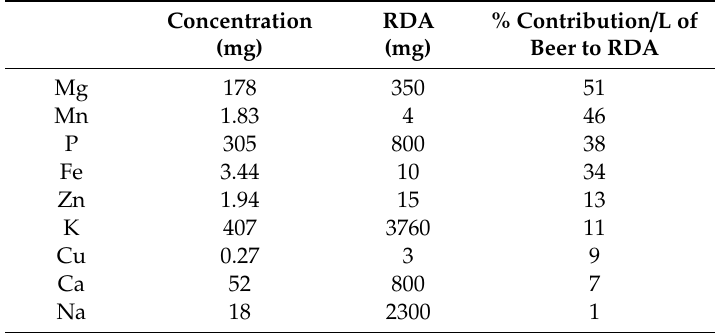
Table 4. The mineral content in umqombothi derived from sorghum adjunct and percentage contribution to the recommend daily allowance (RDA) by a litre of the beer. Concentration RDA % Contribution / L of (mg) (mg) Beer to RDA Mg 178 350 51 Mn 1.83 4 46 P 305 800 38 Fe 3.44 10 34 Zn 1.94 15 13 K 407 3760 11 Cu 0.27 3 9 Ca 52 800 7 Na 18 2300